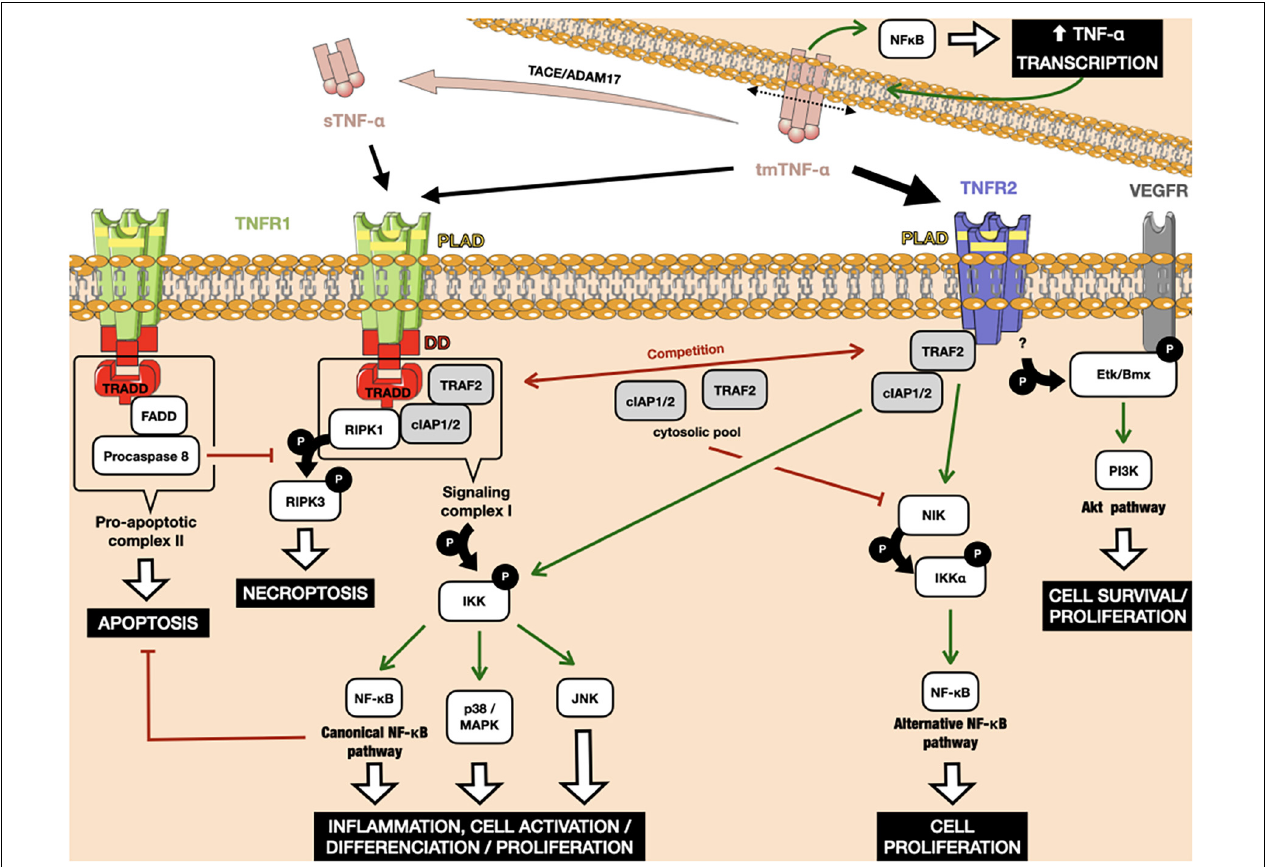
FIGURE 1 | Interplay between the TNFR1 and TNFR2 downstream signaling pathways. TNFR1 can bind to tm-TNF- α , as well as its soluble form after cleavage by the metalloproteinase TACE/ADAM17. TNFR2 binds to tm-TNF- α with higher affinity. Binding of Tm-TNF- α to TNFRs induces a positive retro-control loop on its transcription. TNFR1 activation can lead to apoptosis and necroptosis through interaction between its death domains and the TRADD adaptor. Both TNFR1 and TNFR2 can recruit cIAP1/2, leading to the activation of classical NF- κ B. TRAF2 weakly binds to TNFR2, leading to activation of the alternative NF- κ B pathway. The amount of cIAP1/2 and TRAF2 in the cytosol is crucial in cells that simultaneously express TNFR1 and TNFR2, as the consumption of these molecular actors after TNFR2 activation leads to the preferential activation of death pathways under TNFR1 rather than those of proliferation and survival. Red arrows indicate inhibition. Green arrows indicate activation. P: